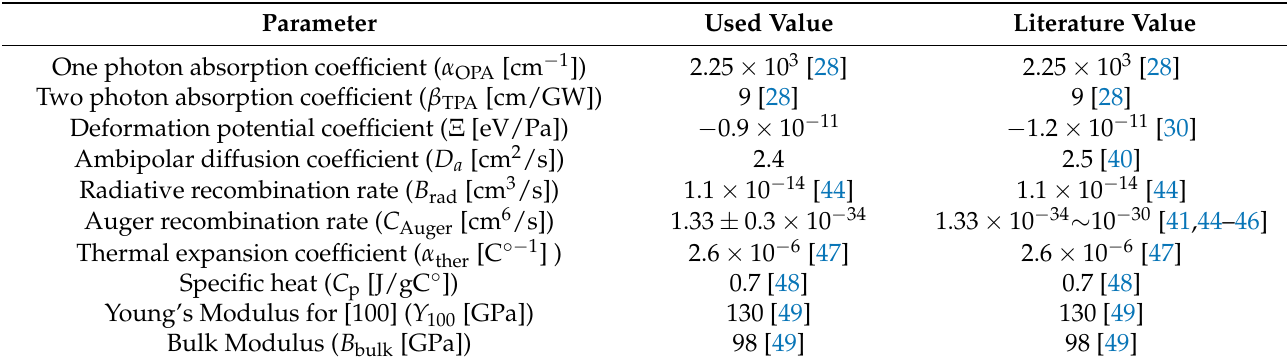
Table 1. Modeling parameters in this